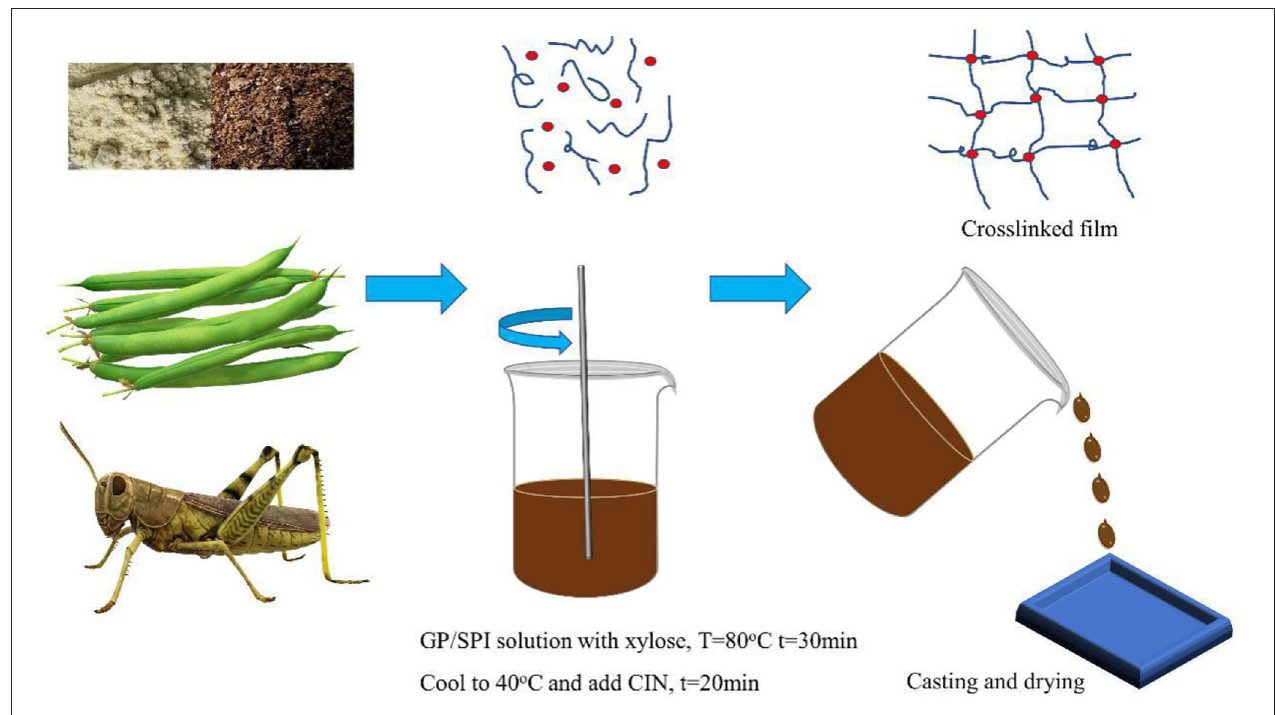
FIGURE 1 | The schematic diagram of this